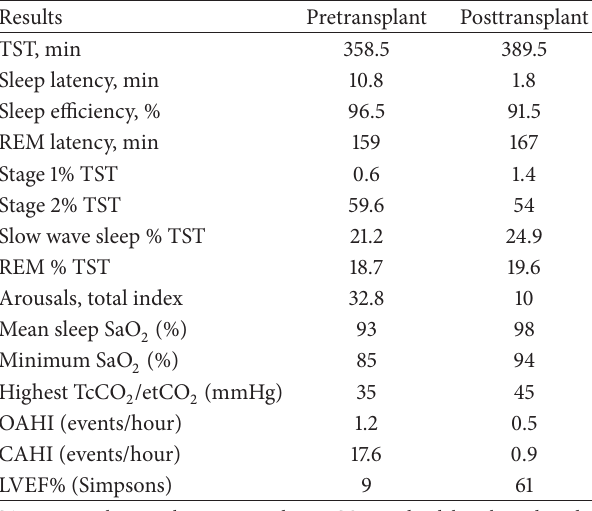
Table 1: PSG results of the patient before and after heart